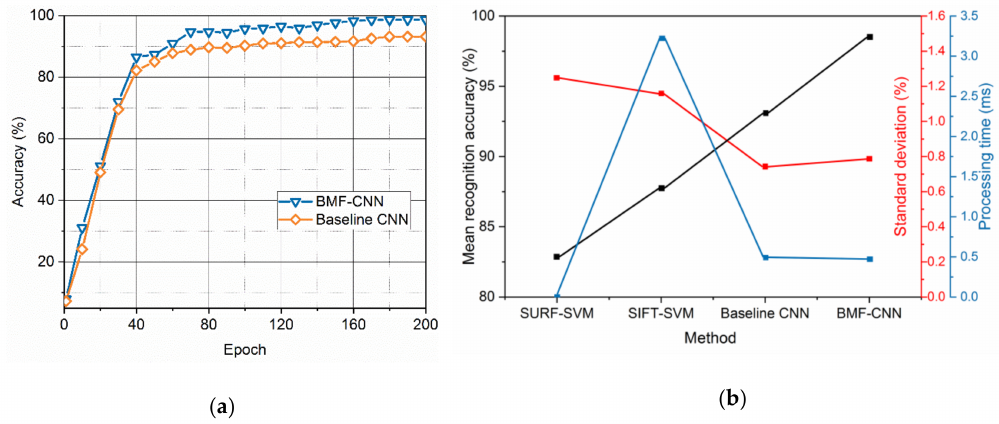
Figure 5. Recognition accuracy. ( a ) The test accuracy of the BMF-CNN and the baseline CNN on the same dataset; ( b ) performance comparison of SURF-SVM, SIFT-SVM, traditional CNN and BMF-CNN (mean recognition accuracy, standard deviation, and processing